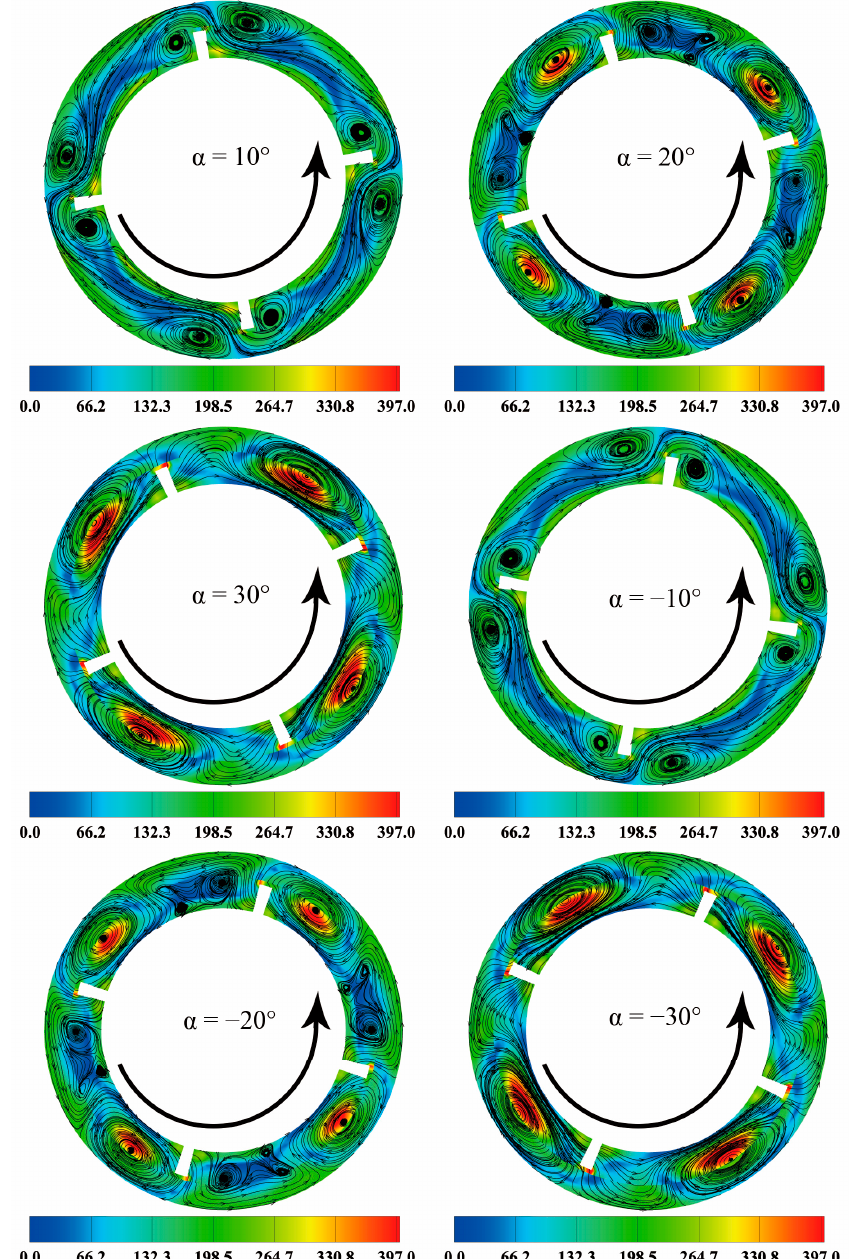
Figure 17. Vorticity distribution and the stream traces at the end cross-section of the V-shaped blade with different helical angles.